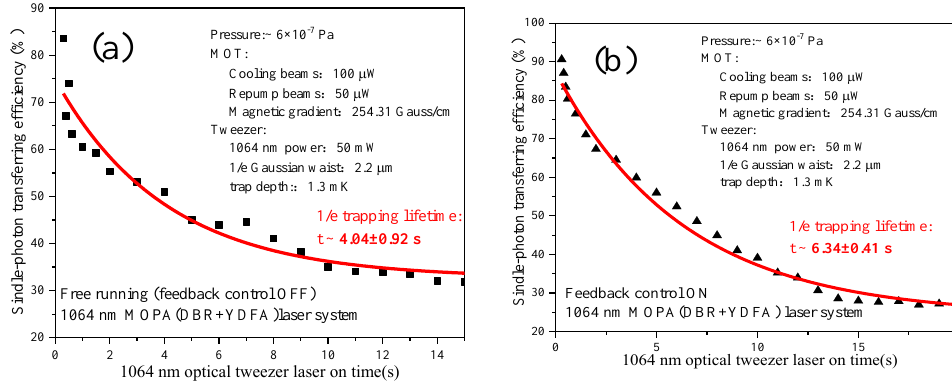
Figure 10. Trapping lifetime of atom in 1064-nm optical tweezer when the feedback loop is turned off ( a ) and on ( b ). The trapping lifetime of single-atom is extended from 4.04 s to 6.34 s.